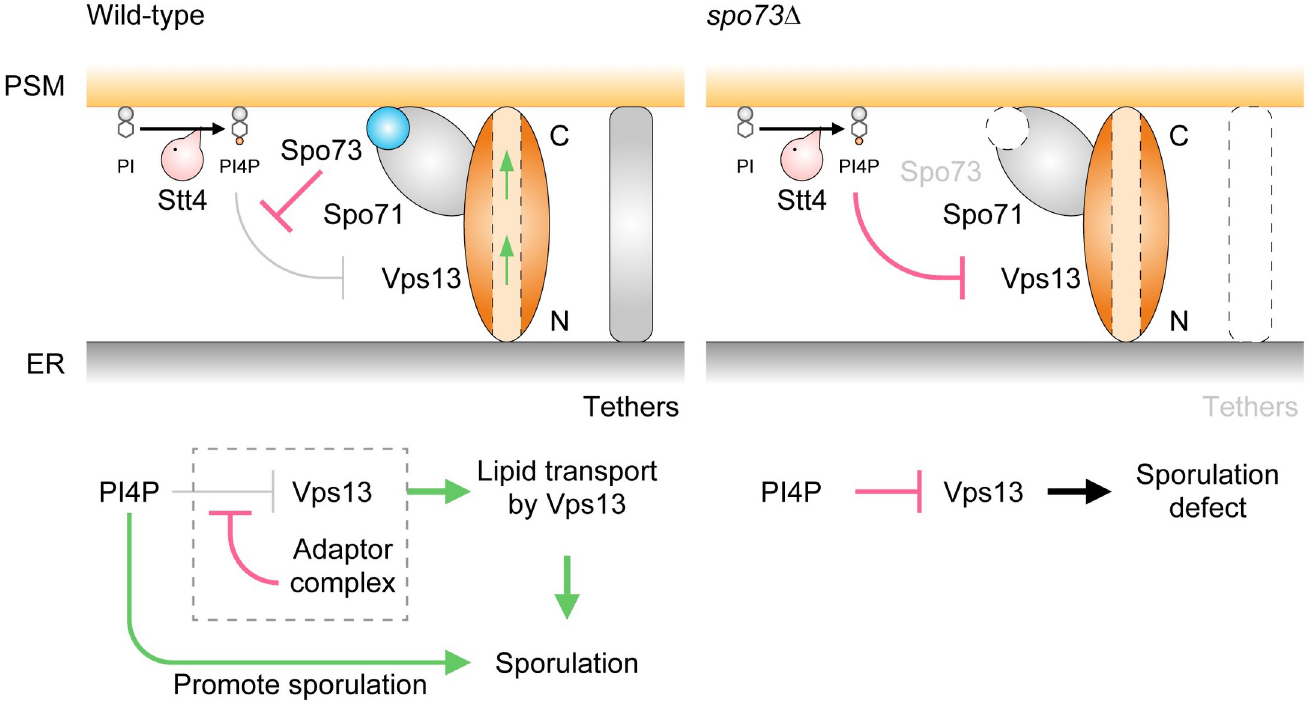
Fig 9. Hypothetical model of this study. Left: Model of PSM extension by Vps13, the adaptor complex, and ER-PM tethers through the regulation of PI4P levels in wild-type cells. Right: Model of PSM extension defect in spo73 Δ cells.